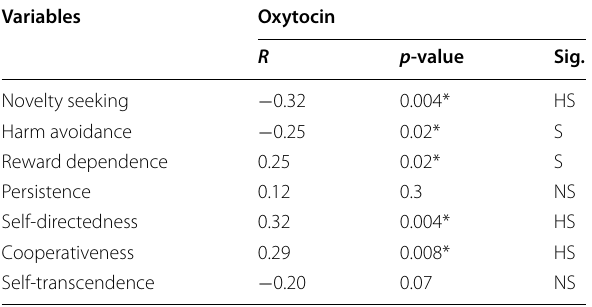
Table 5 Comparisons of oxytocin level in different